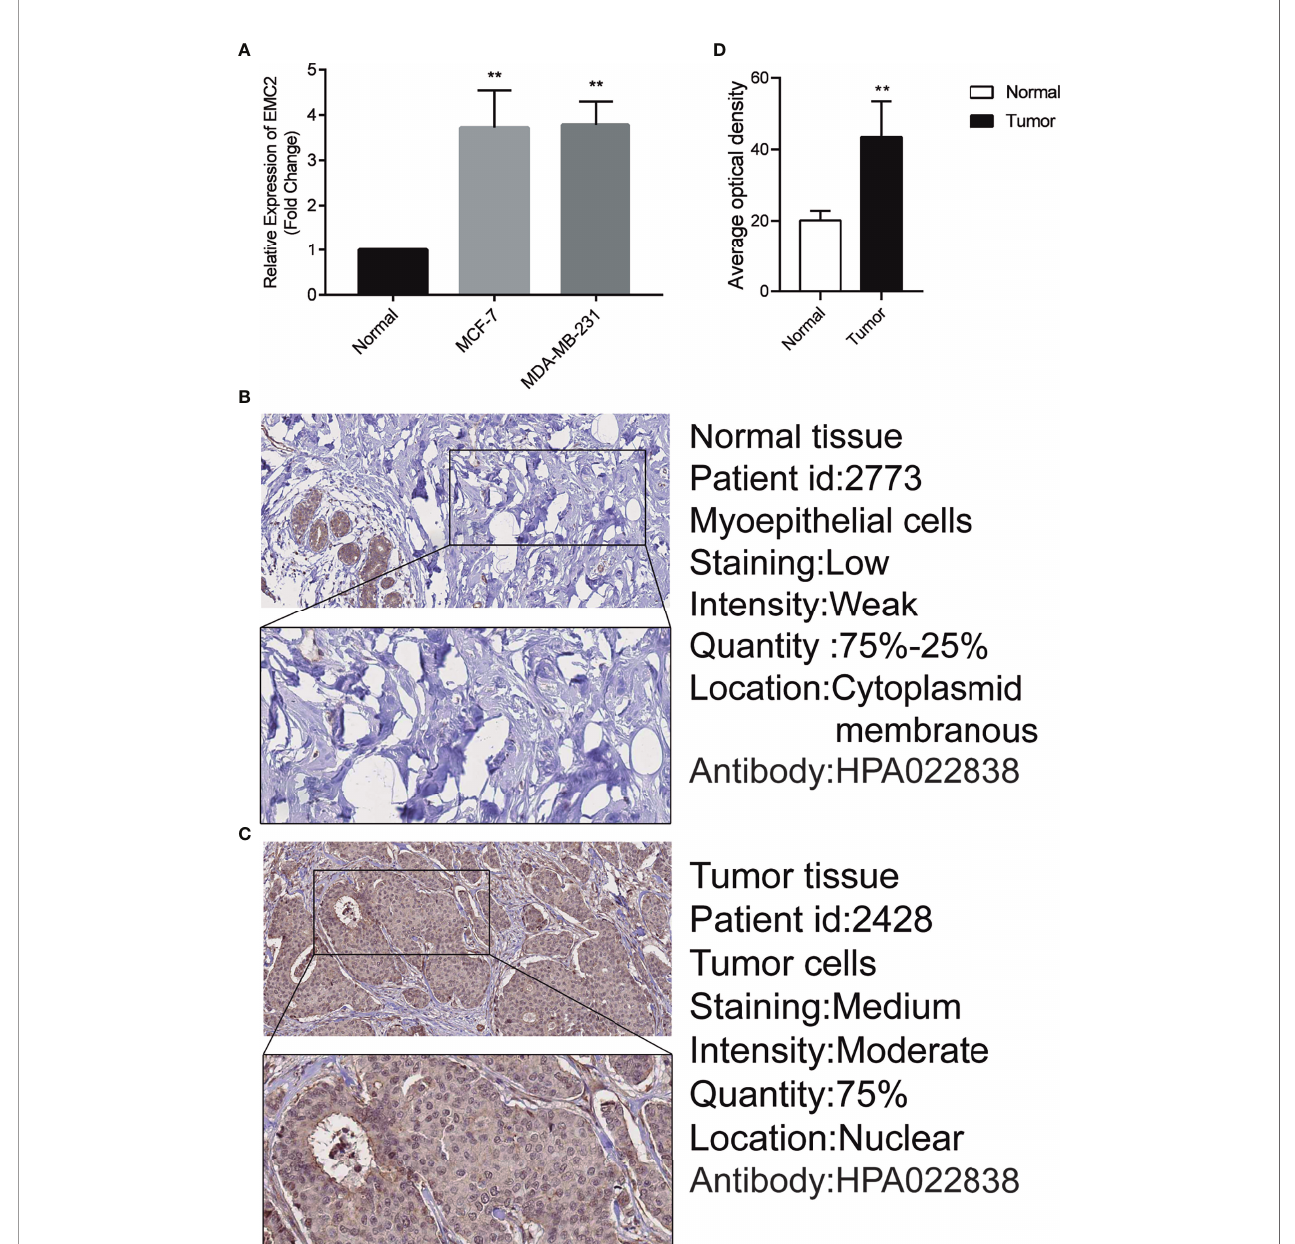
FIGURE 8 | Expression of EMC2 in breast cancer cells and tissues. (A) Expression analysis of EMC2 in breast normal and tumor cells. (B – D) Expression analysis of EMC2 in breast normal and tumor tissues. **p <